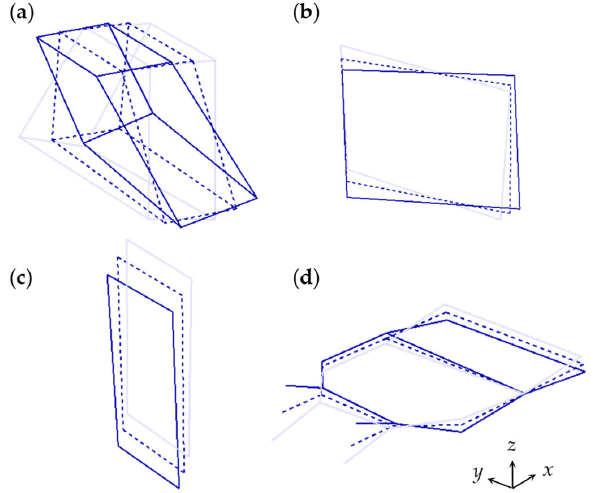
Figure 5. Operational deflection shapes of various components at the idling frequency of 27.7 Hz: ( a ) powertrain; ( b ) radiator; ( c ) intercooler; and ( d ) body floor.